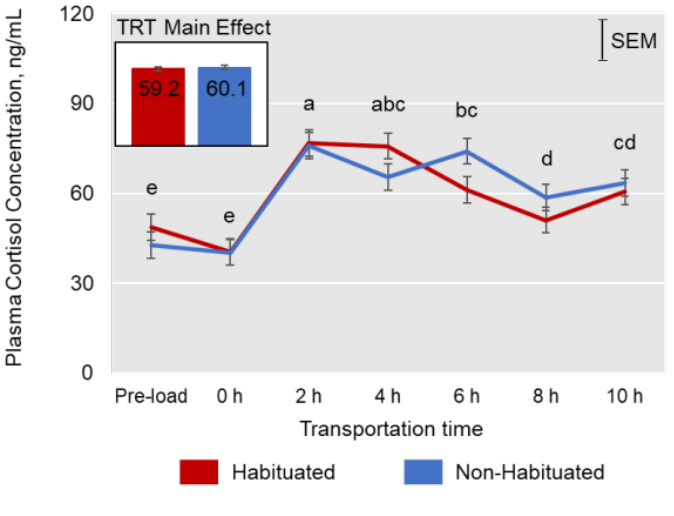
TRT × Time effect ( p < 0.05; Figure 2) on CK activities, with the values increasing in the NH group and decreasing in the H group during the first two hours of transportation. Among the different types of leukocytes counted, lymphocyte (L) count decreased ( p < 0.01) and neutrophil (N) count and N/L ratio increased ( p < 0.01) over Time (Table 2).